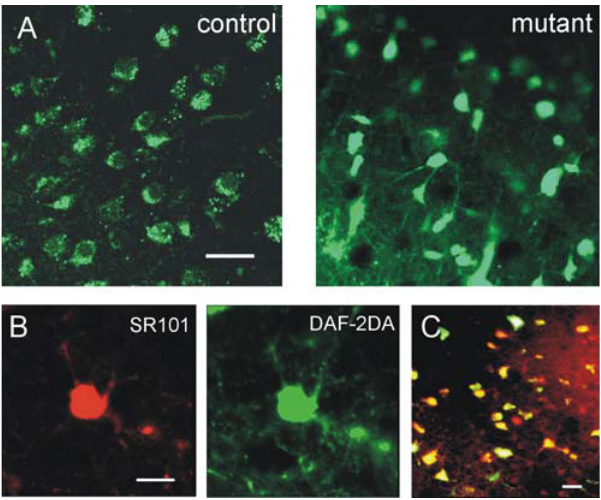
Figure 2. Diffusely-stained astrocytes are prevalent in confocal images from mutant mice. (A) Example of confocal images from DAF- 2DA incubated neocortical slices. Punctate, putative neuronal staining is dominating in slices from control mice (left), and diffuse fluorescence is dominating in the mutant’s slice (right). Scale bar=25 m m. (B) Diffuse DAF-2DA staining (green) is co-localized with the specific astrocytic marker SR101 (red). Examples from confocal images of a single cell are displayed. Scale bar=10 m m. (C) Merging image of SR101 and DAF-2DA staining (projection of four 5 m m thick images). Cells which stain with both dyes appear in yellow. Over 95% of the cells displayed co- localization (4 slices, 2 animals). Scale bar=20 m m.